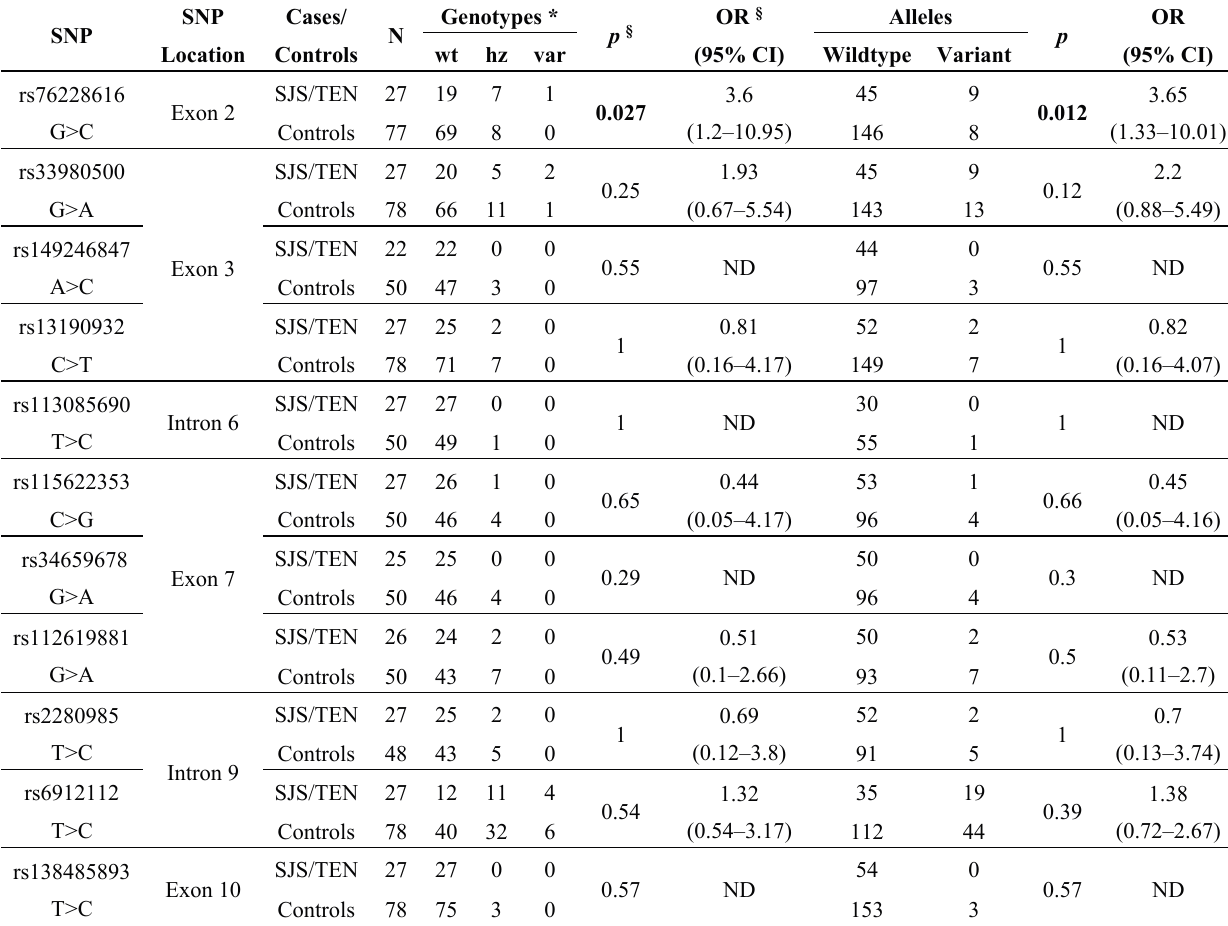
Table 2. TRAF3IP2 genotypes and alleles distribution in Steven–Johnson Syndrome (SJS)/ Toxic Epidermal Necrolysis (TEN) and controls.